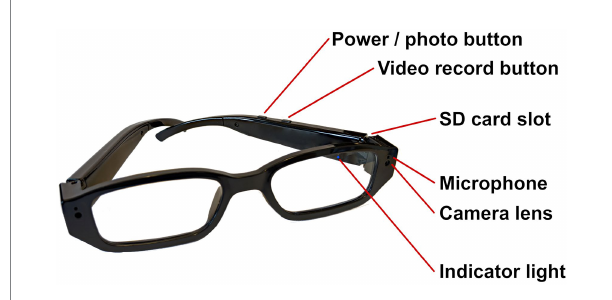
FIGURE 1 Example of the spyglasses used by students in the